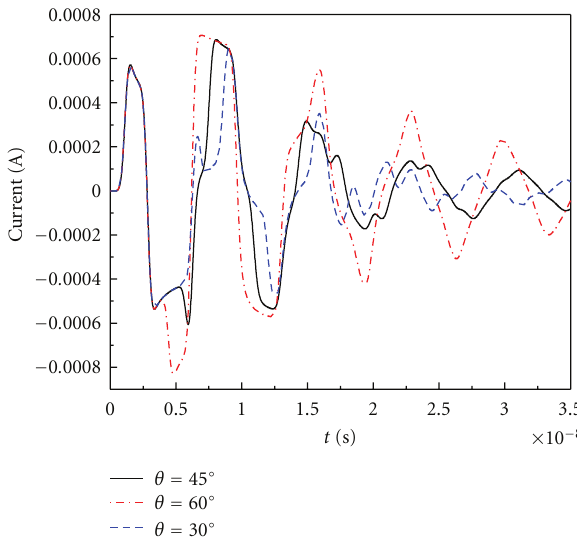
Figure 9: The current induced at midpoint of thin wire with di ff erent incident